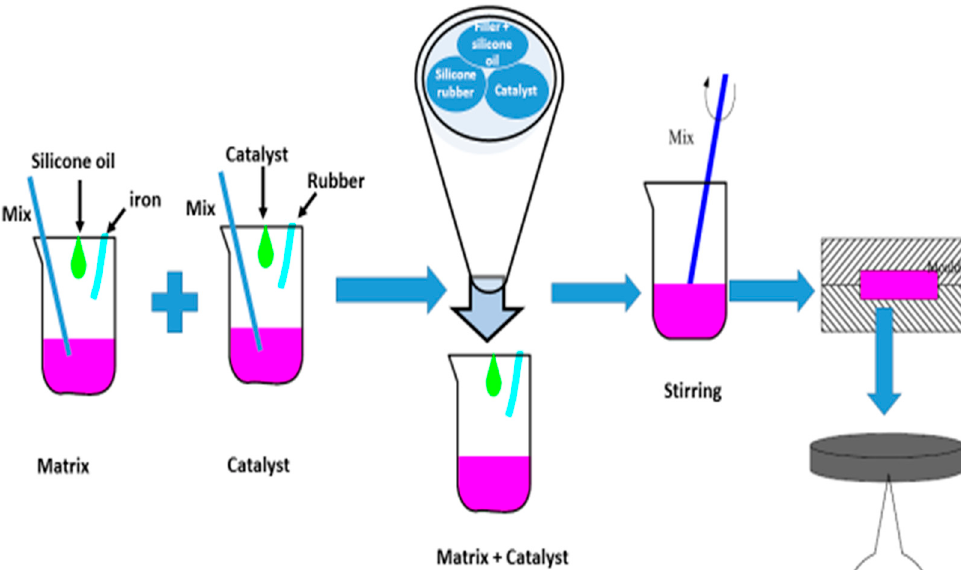
Figure 4. Fabrication of MRE composite with matrix and iron particles with presence of magnetic field. Reprinted from [19], © 2016 with permission from Elsevier.